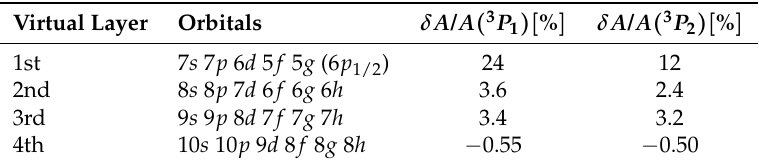
Table 1. Orbitals included in the different virtual layers. The parentheses around orbital 6 p 1/2 indicates that it was included only for the 3 P 2 state. δ A / A is the relative change in the hyperfine structure constant from the preceding